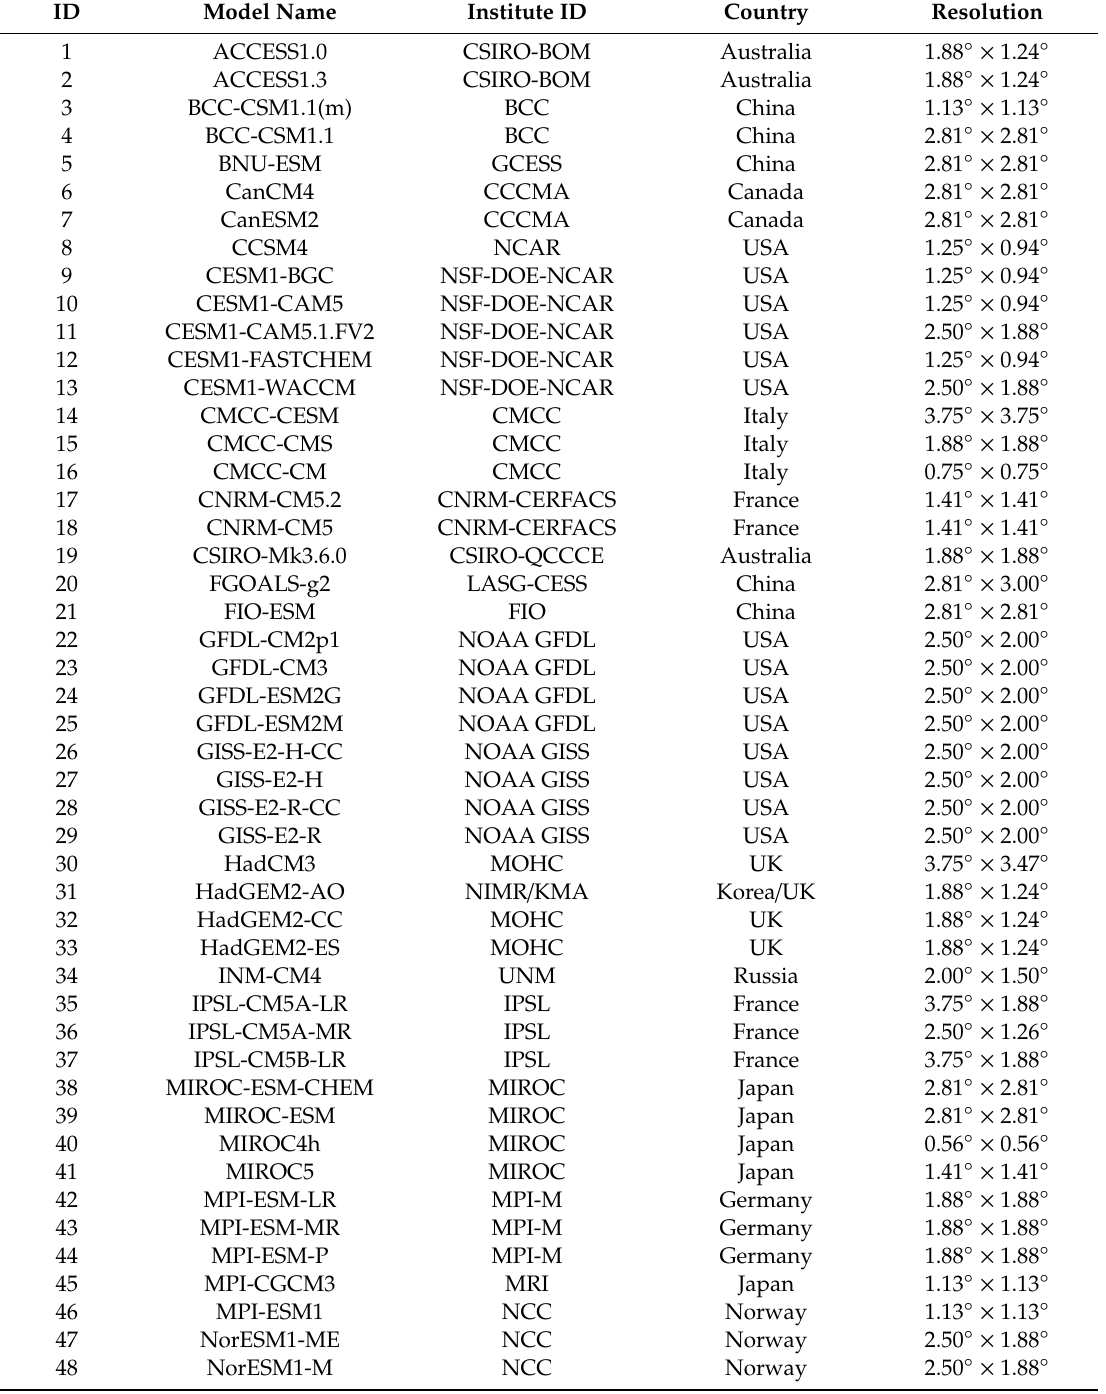
Table1. DetailedinformationoftheCoupledModelIntercomparisonProject(CMIP5)generalcirculation models (GCMs) used in this